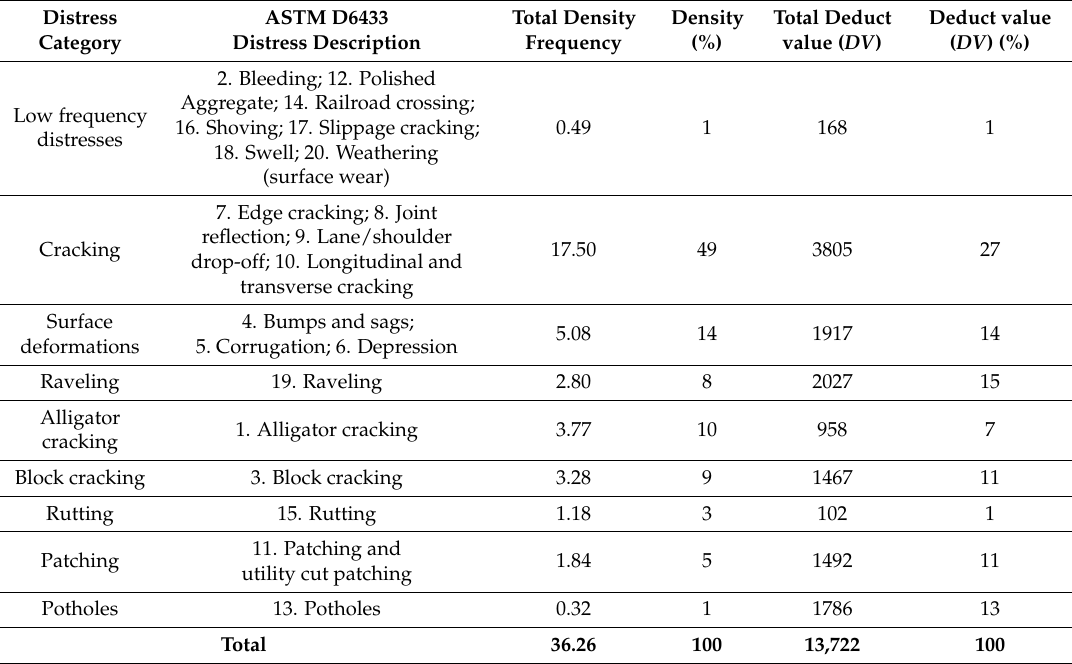
Table 2. Distress frequency in an Italian road